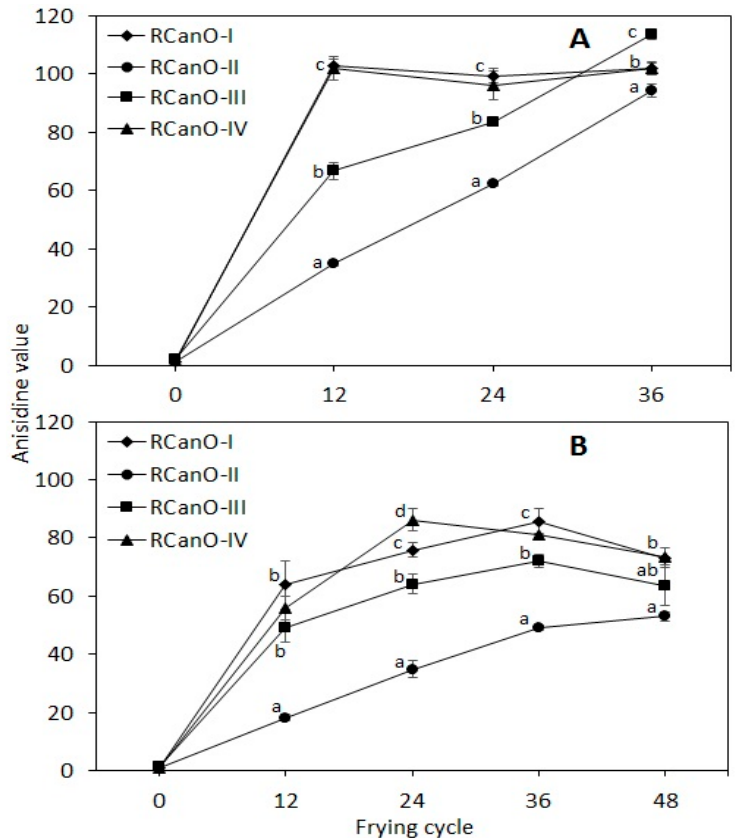
Figure 6. Formation of nonvolatile carbonyls (as p-anisidine) during 36 and 48 frying cycles: ( A ) 2016/2017 ( n = 36) and ( B ) 2017/2018 ( n = 48) production seasons. Different letters show means that are statistically significant from each other ( p < 0.05).